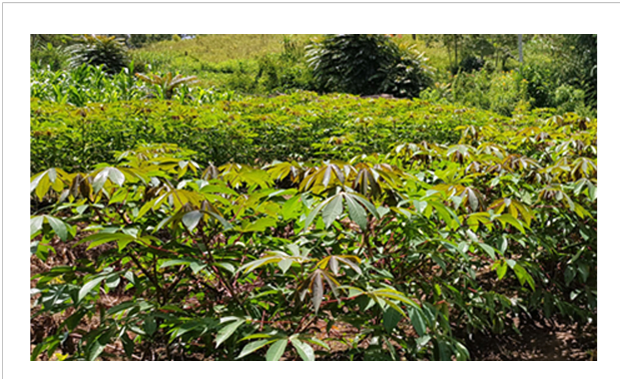
FIGURE 5 Cassava seedling DSC 493, 6 months after planting in an epidemic zone for CBSD and CMD near Uvira, DR Congo. The line is free of symptoms and shows vigorous